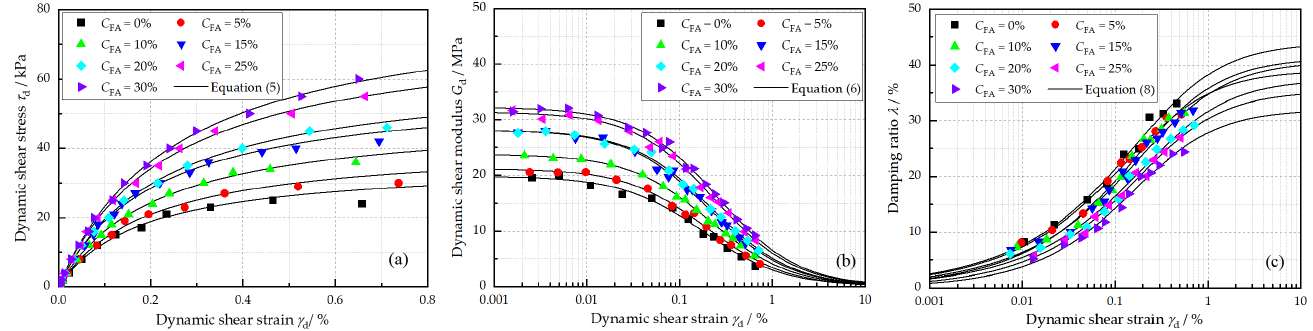
Figure 6. Effects of fly ash on ( a ) backbone curve, ( b ) dynamic shear modulus, and ( c ) damping ratio